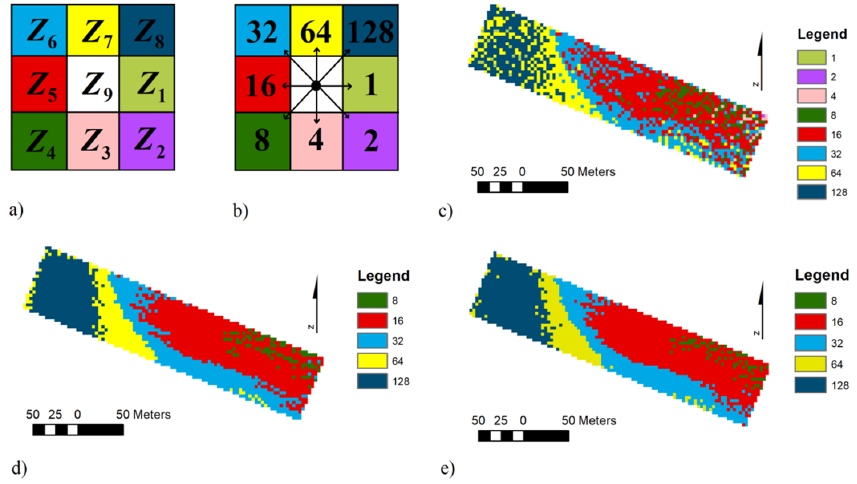
Figure 4. Compacts of numeration of DEMs: ( a ) the standard system of cells, ( b ) coding directions of flow by the D8 algorithms [62], ( c ) map of flow direction, D8, Method I, APs, ( d ) map of flow direction, D8, Method II, ALSs, ( e ) map of flow direction, D8, Method III, TLSs.